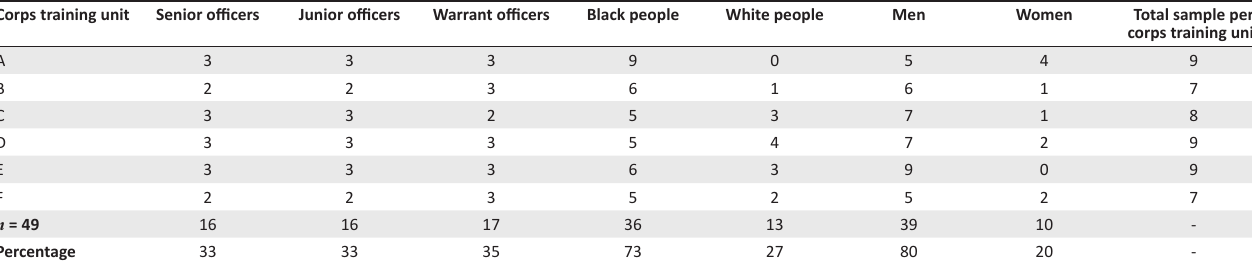
TABLE 1: Profile of participants’ demographic information. Corps training